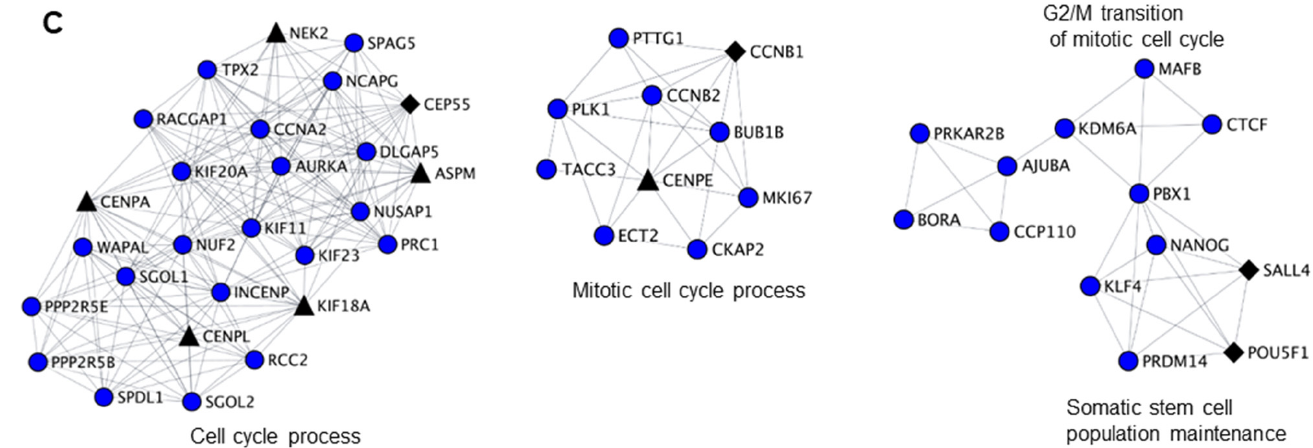
Figure 2. Biological clustering analysis (BCA) reveals cell cycle related functions for NANOS1 and NANOS3. ( A ) Workflow for biological clustering analysis (BCA). High confidence (score ≥ 0.9) protein–protein interaction networks of differentially expressed genes are created using the STRING database followed by cluster detection by MCODE. Further, these clusters were subjected to gene ontology (GO) search for the corresponding biological process. ( B ) NANOS1 and ( C ) NANOS3 downregulated cell cycle cluster containing infertility (shown in black diamonds, Supplementary Table S3) and cancer-germ cell genes (shown in black triangles, Supplementary Table S4).